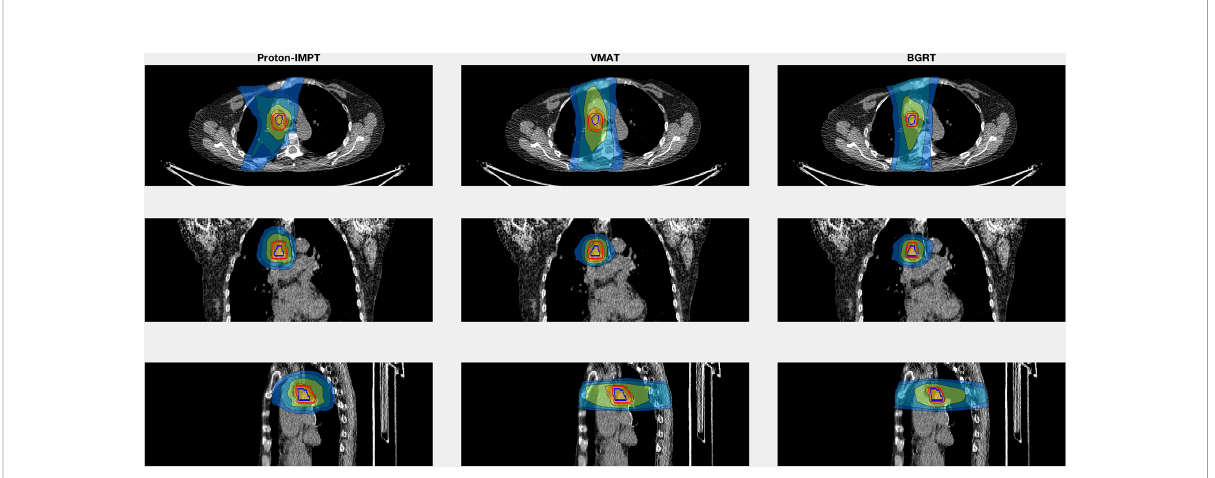
FIGURE 3 Isodose line images for case 1, involving a right lower paratracheal node recurrence after two VMAT regimens for a right middle lobe bronchoalveolar carcinoma. Isodose lines depicted are 10 Gy (blue), 20 Gy (teal), 40 Gy (green), and 60 Gy (yellow). GTV is contoured in blue. PTV displayed in red (6 mm GTV expansion for IMPT and VMAT and 3 mm for